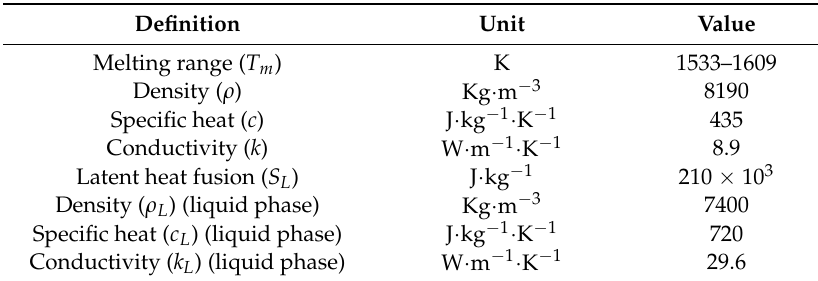
Table 5. Properties of Inconel 718 (average thermophysical properties of Inconel 718, Copyright © 2002 Woodhead [37]).